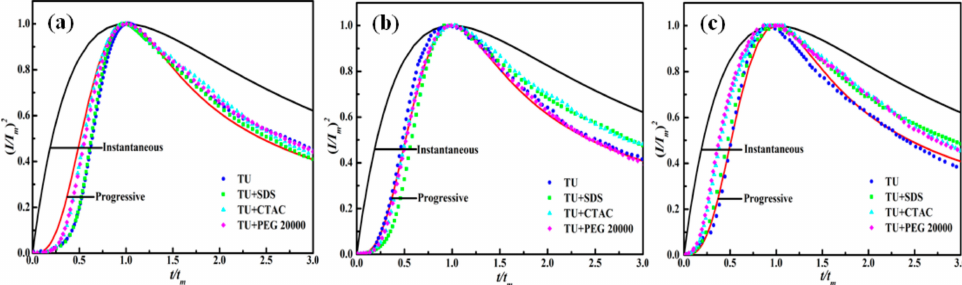
Figure 4. Corresponding Scharifker–Hills’ models for nickel electrodeposition at different potentials.